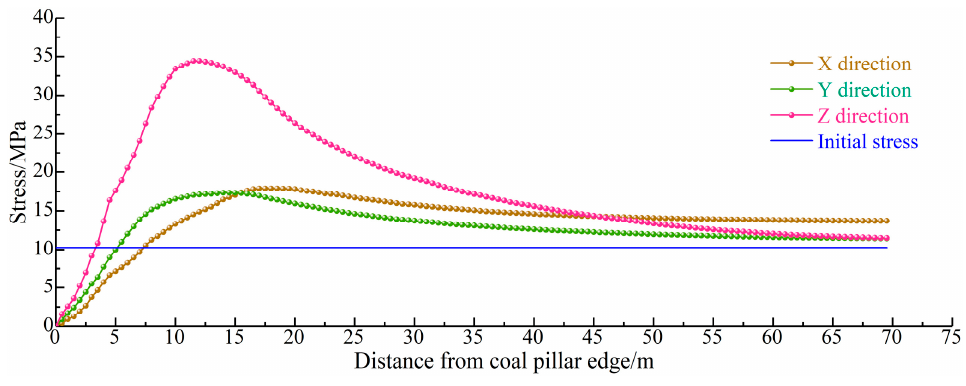
Figure 7. Lines of lateral stress distribution.